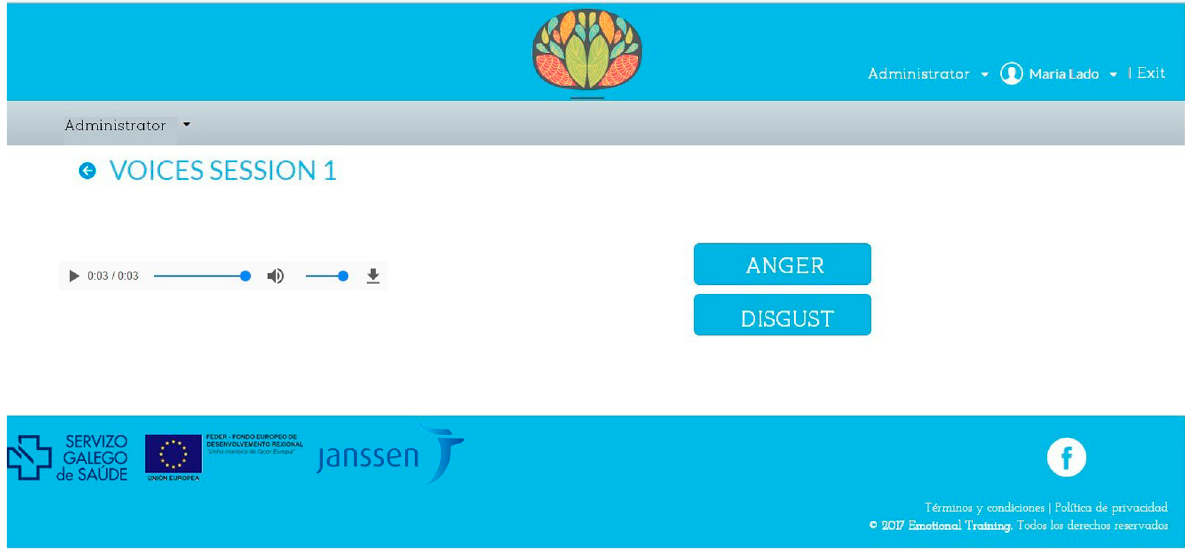
Fig 2. Sessions for Voices . Reprinted from www.e-motionaltraining.com under a CC BY license, with permission from Fundacio´n Biome´dica Galicia Sur, original copyright 2018.